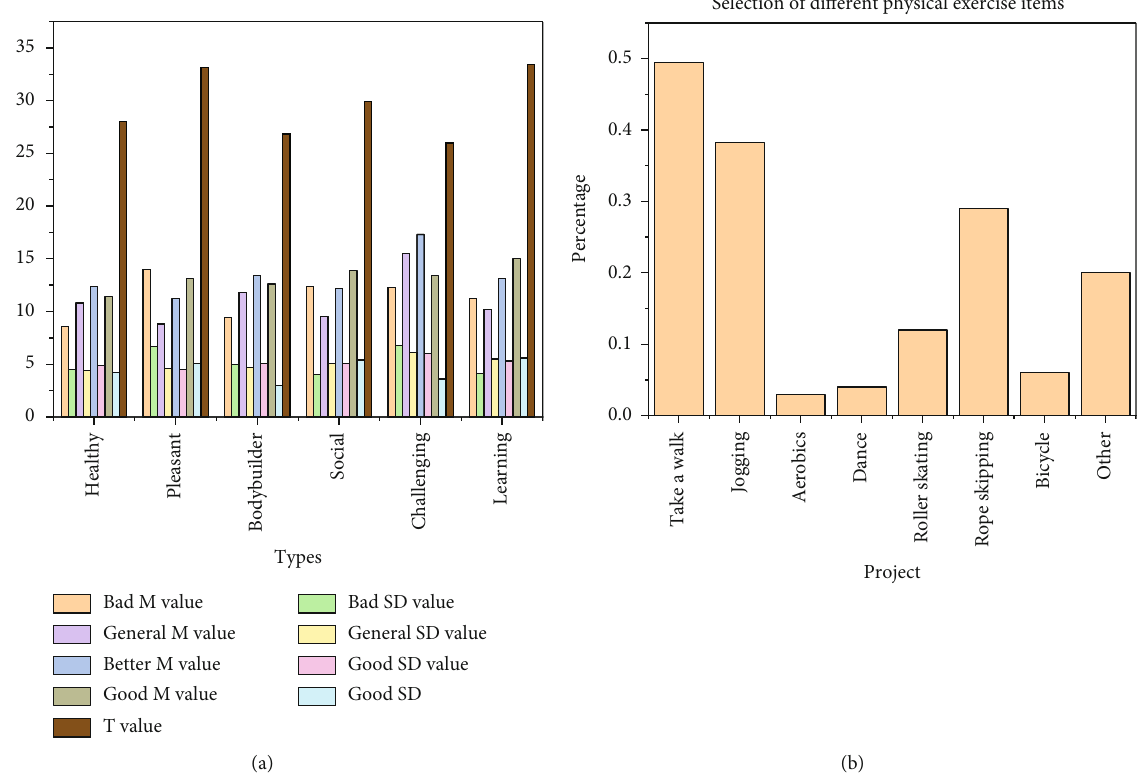
Figure 3: The results of self-evaluation of physical exercise motivation in di ff erent self-conditions and project selection ((a) self-evaluation of di ff erent self-conditions; (b) project